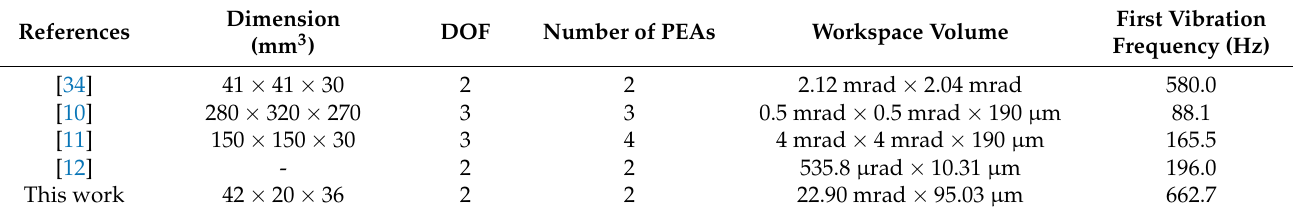
Figure 15. ( a ) Symmetrical rotation. ( b ) 5 Hz translation. ( c ) 100 Hz translation. ( d ) Parasitic motion. ( e ) Alternating translational rotation. ( f ) Simultaneous translational rotation. Table 6. Performance comparison with other